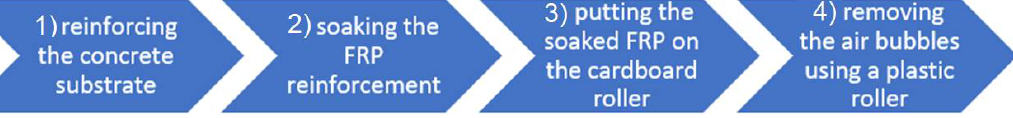
Figure 6. Stages in the wet lay-up process, adapted from [37].